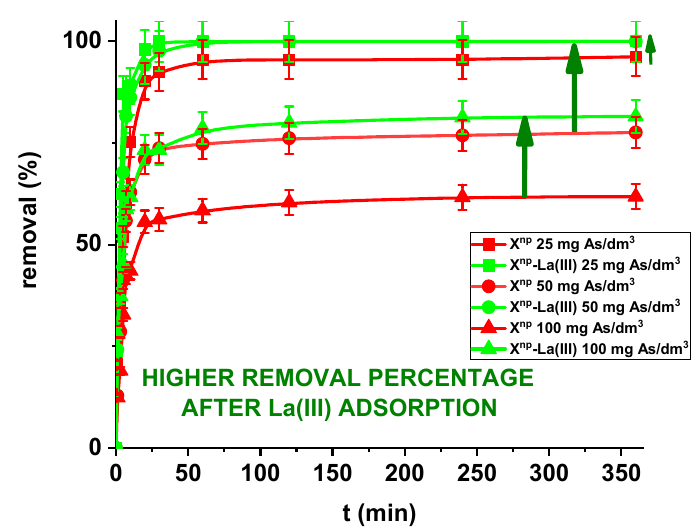
Figure 12. Arsenic(V) sorption efficiency for X np and X np -La(III) (c 0 = 25, 50 and 100 mg/dm 3 , pH = 6, shaking speed 180 rpm, temperature 295 K).